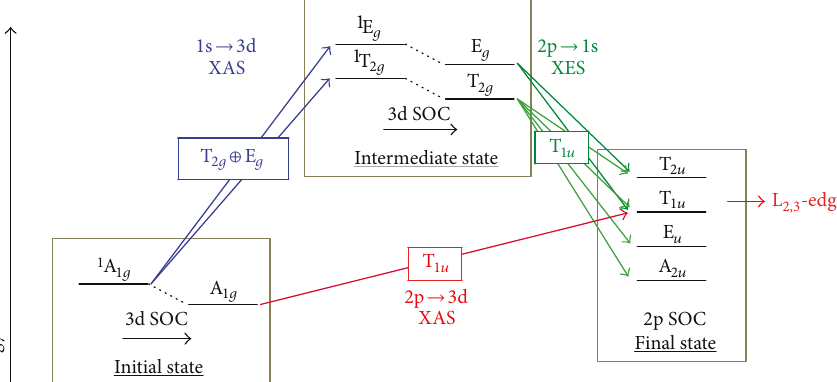
Figure 15: Multielectronic term scheme comparing the 2p XAS and the 1s2p RIXS pathways. The two quadrupole 1s XAS transitions with T and E symmetry lead to two di ff erent intermediate state symmetries. The subsequent dipole decays (2p XES) with T 2 g g multiple 1s2p RIXS fi nal state symmetries. The direct 2p XAS (L symmetry in the fi nal state. Noncontributing states are omitted for T 1 u